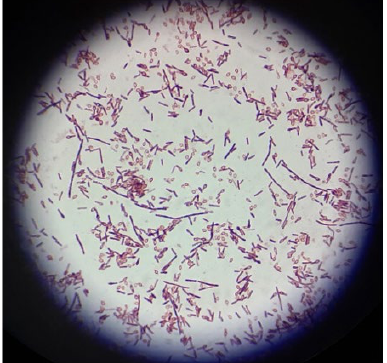
Fig. 2. Gram stain of culture isolates shows mixed growth with most bacillus